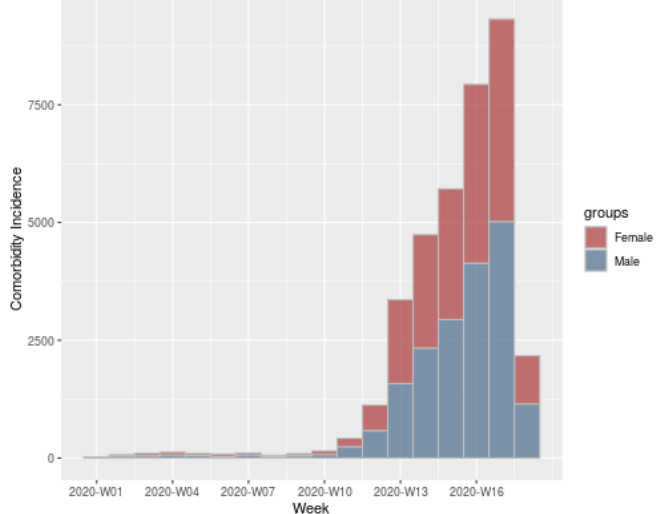
Figure 12. Comorbidity incidence of the population from all the territory with positive